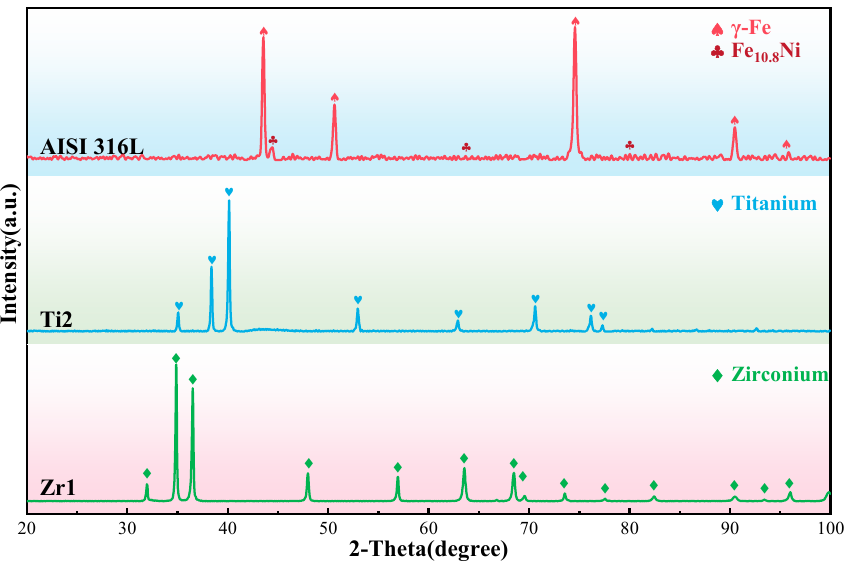
Figure 2. XRD patterns of AISI 316L, Ti2, and Zr1.